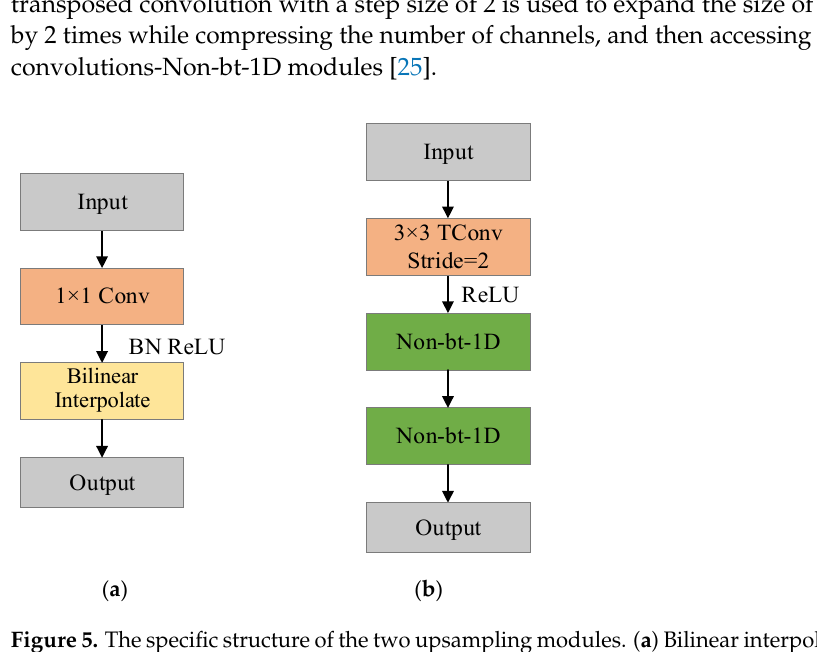
Figure 4. Adaptive upsampling module.